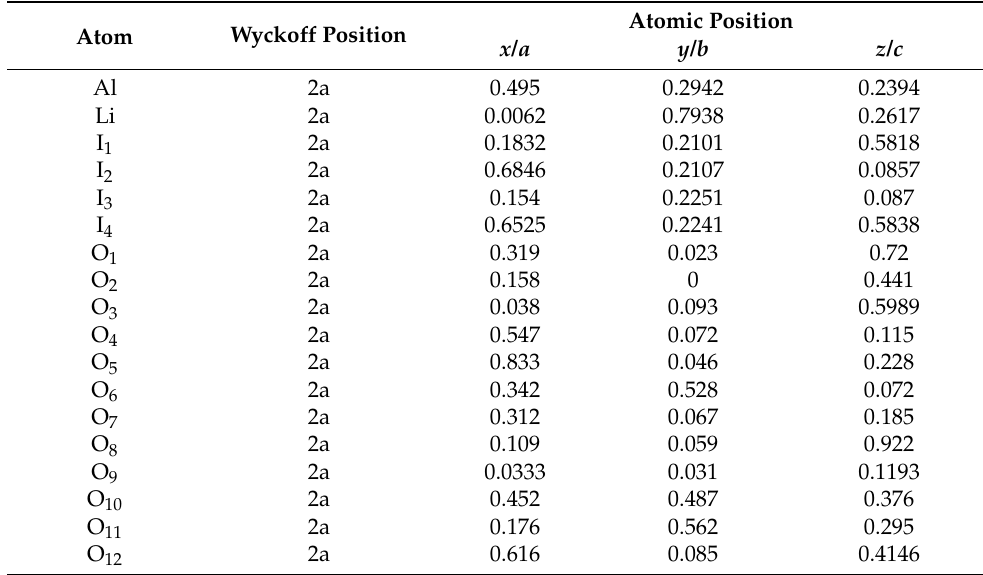
Table 1. Atomic positions of LiAl(IO 3 ) 4 .